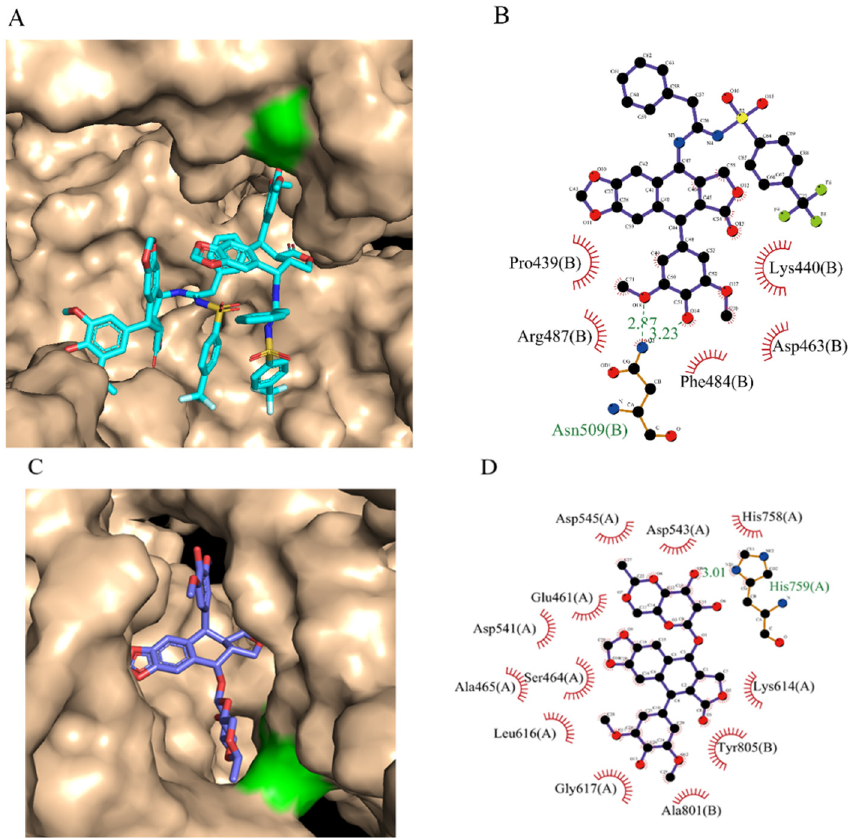
Figure 4. Molecular docking of topoisomerase-II with PSAH 5c . ( A ) 3D action diagram. The turquoise stick represents 5c . ( B ) 2D action diagram. ( C ) 3D action diagram of Etoposide. The blue stick represents podophyllotoxin. ( D ) 2D action diagram of